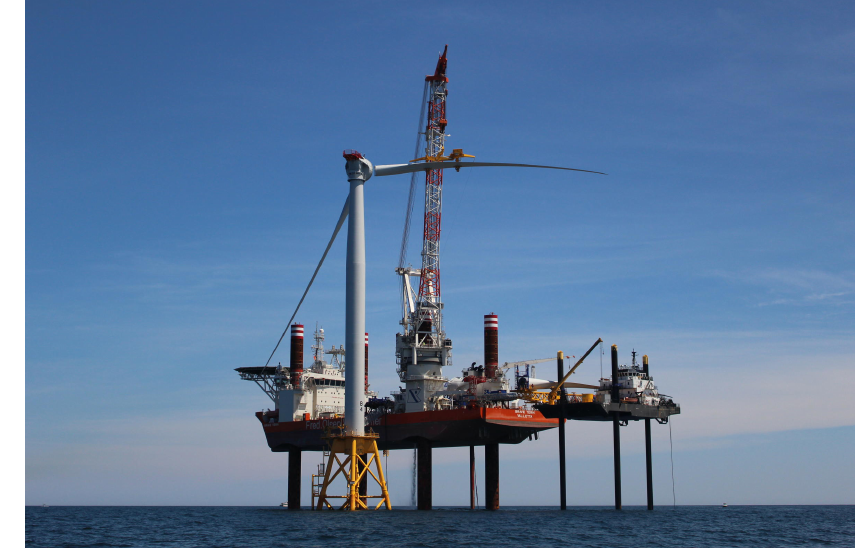
Figure 1. Single blade installation (Image source: RIPR